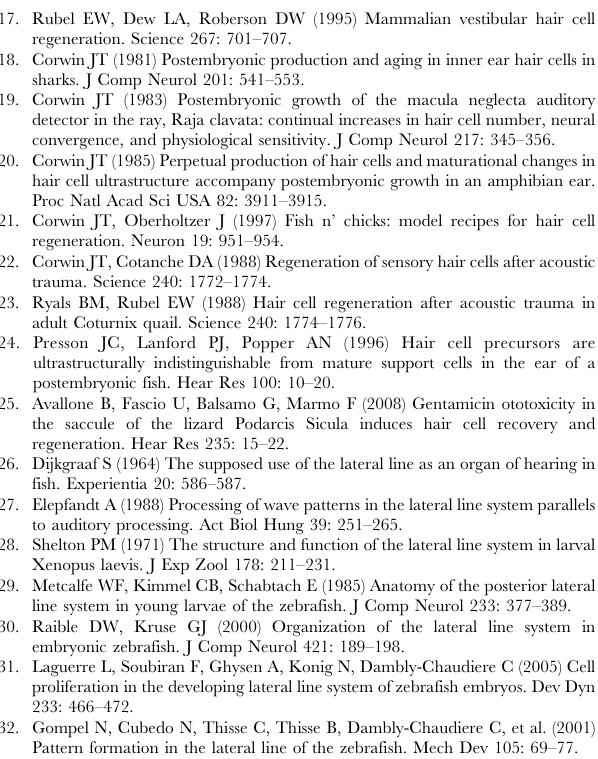
Figure S1 Live imaging of transgenic lines crossed into the phoenix background show no differences from wild-type larvae. A. We crossed the phoenix mutant line into the cldnB::GFP transgenic background, which expressed GFP (green in first and third panels) in all cells of the neuromast. We stained untreated 5 dpf larvae with FM1-43 (red in second and third a panel). Shown are images of live wild-type (top panels) and phoenix (bottom panels) neuromasts. A camera lucida drawing of each merged picture is highlighting the GFP positive cells contours (green) and the FM1- 43 positive cells (red) in the fourth panel. B. We crossed the phoenix mutant line into the pou4f3::GFP transgenic background, which expressed GFP in all of the neuromast’s hair cells. Dorsal views (left panels) and lateral views (right panels) of wild-type (top panels) and pho/pho (bottom panels) are shown. A camera lucida drawing of each panel is outlining the GFP positive hair cells of each respective 41 panel. C. We crossed the phoenix mutant into the ET20::GFP transgenic background, which expressed GFP in a subset of supporting cells known as the mantle cells. Two representative examples of wild-type (top panels) and of phoenix mutant (bottom panels) neuromasts are shown. A camera lucida drawing of each panel is outlining the GFP + cells of each respective panel. - 10 microns in all panels. Figure S2 Hair cells seem unaffected in the phoenix mutant ear. Wild-type expression of the phoenix mRNA and protein. A. Live images in pou4f3;;GFP transgenic animals of hair cells in a crista of a wild-type (left panel) and a phoenix mutant (right panel) ear. B. In situ hybridization with an antisense probe against phoenix in the inner ear of a 4dpf old embryo (top panel). A camera lucida drawing (lower panel) shows the positions of the two otoliths (red), of the cristae’s (light green) and the maculae’s (dark green) hair cells. The